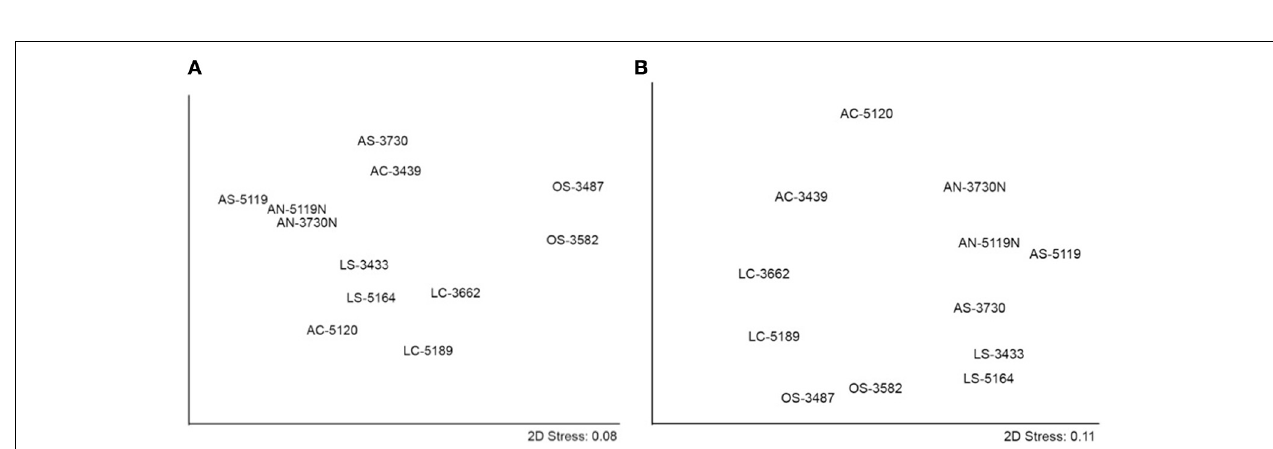
FIGURE 5 | Non-metric MDS showing (A) archaeal and (B) bacterial communities derived from genus-level relative